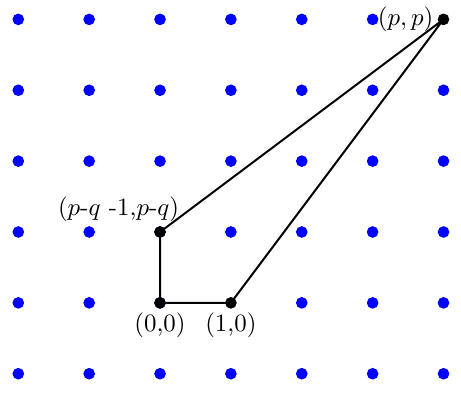
Figure 2 . Toric diagram for Y p;q . The (cid:12)gure depicts the case p = 4 and q =